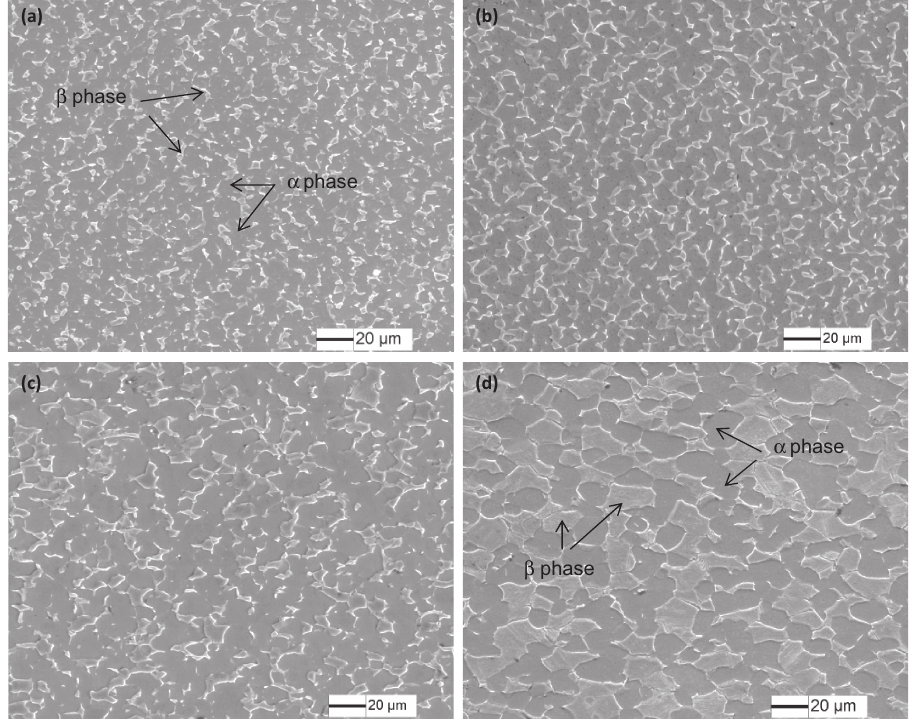
Figure 5: The microstructures of the specimens in the temperature range of 850 – 950 ℃ (a) 850 ℃ , (b) 880 ℃ , (c) 900 ℃ , (d) 950 ℃